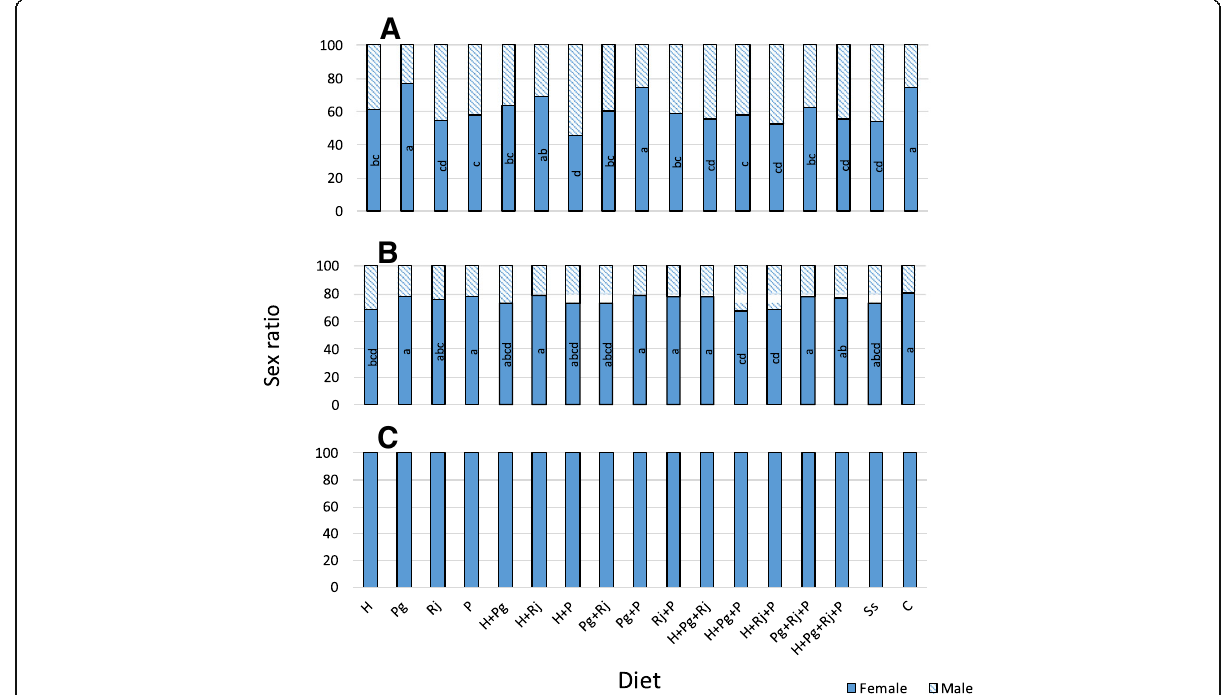
Fig. 5 Sex ratio of a T . evanescens , b T. bourarachae , c T . cacoeciae supplied with different diets and the